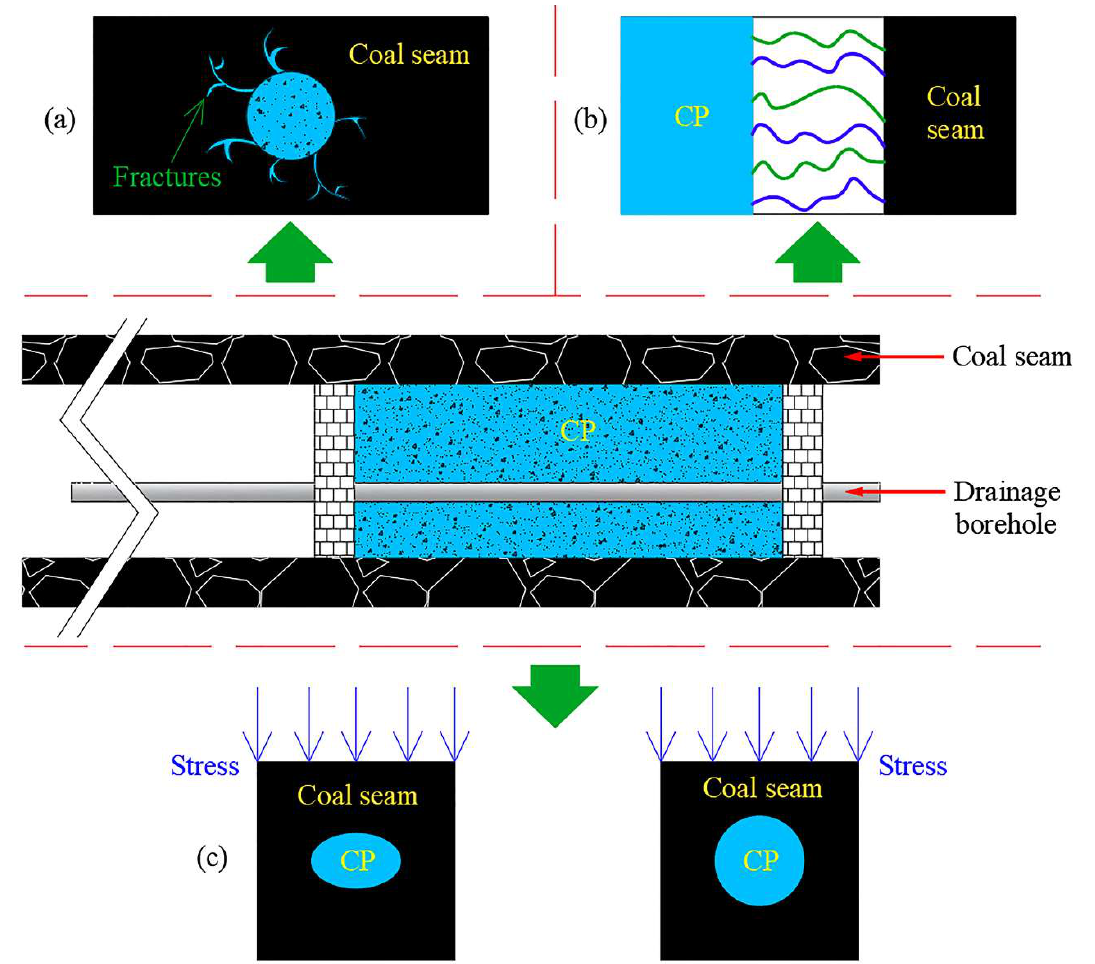
Figure 20. Sealing performance of composite polymer material (CP): ( a ) High fluidity and super sealing ability; ( b ) good combination with coal mass; ( c ) adapt to the deformation of borehole [85].